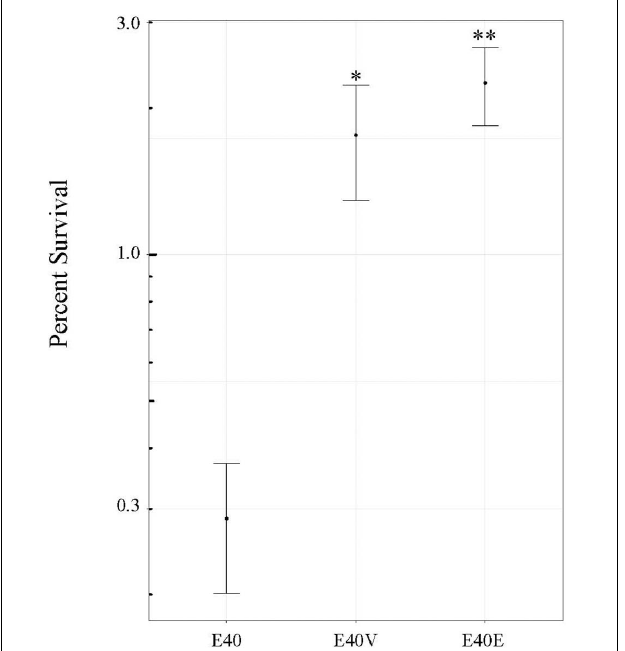
FIGURE 5 | Survival of strains E40, E40V, and E40E at pH 3.0. Strains were inoculated into TSB at pH 3.0 and the number of CFU/ml determined after 6 h of incubation at 37 ◦ C. Percent survival was determined using the number of CFU/ml following inoculation and after 6 h of incubation. The average values from four trials are shown. Error bars are the standard error of the means. ∗ p = 0.02 between E40 and E40V. ∗∗ p = 0.003 between E40 and E40E.